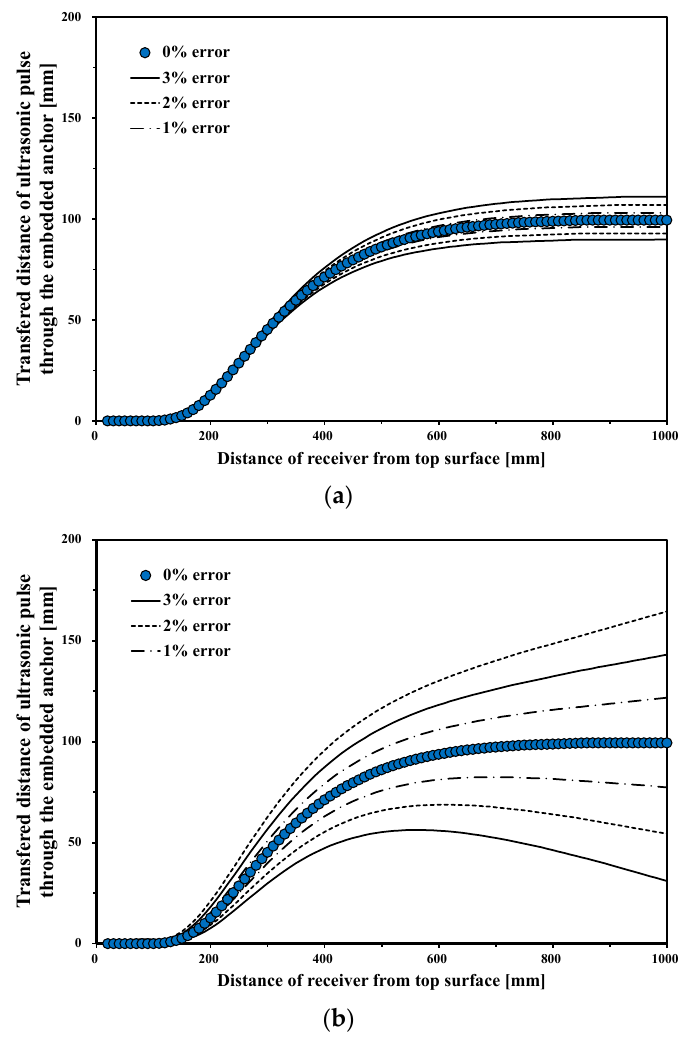
Figure 7. Variation in transferred distance of ultrasonic pulse through the embedded anchor bolt according to the error of ultrasonic velocity in the anchor bolt and concrete: ( a ) error of ultrasonic velocity in the anchor; and ( b ) error of ultrasonic velocity in concrete.